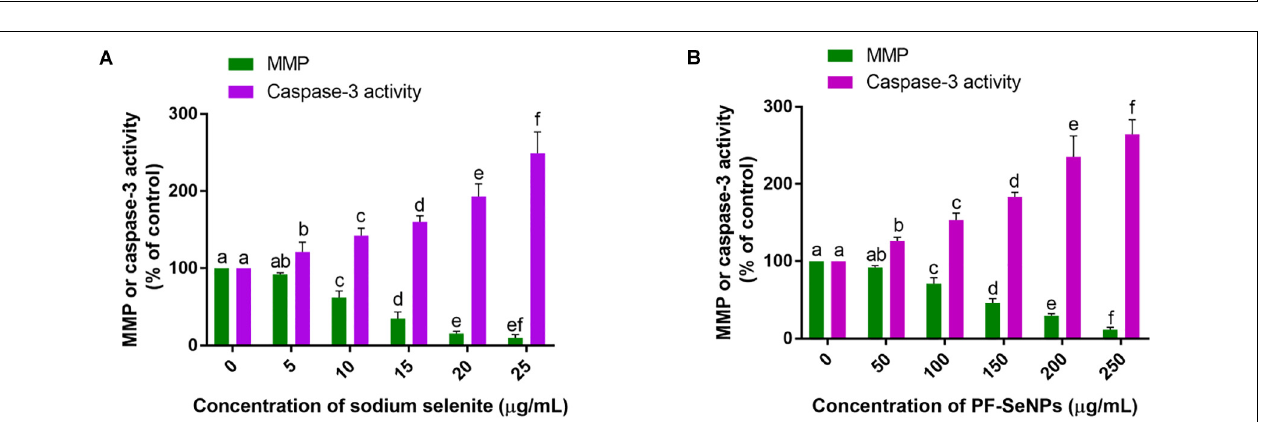
FIGURE 11 | Effect of different concentration of (A) sodium selenite and (B) phytofabricated selenium nanoparticles (PF-SeNPs) on mitochondrial membrane potential (MMP) and caspase-3 activity of N2a cells for 24 h. The experiments were executed independently in triplicates and data was expressed as mean ± SD. The statistical difference between the test samples were assessed by Tukey’s multiple comparison test and p ≤ 0.05 was considered as a significant. The bar graphs with different alphabetic letters within the respective study were significant.